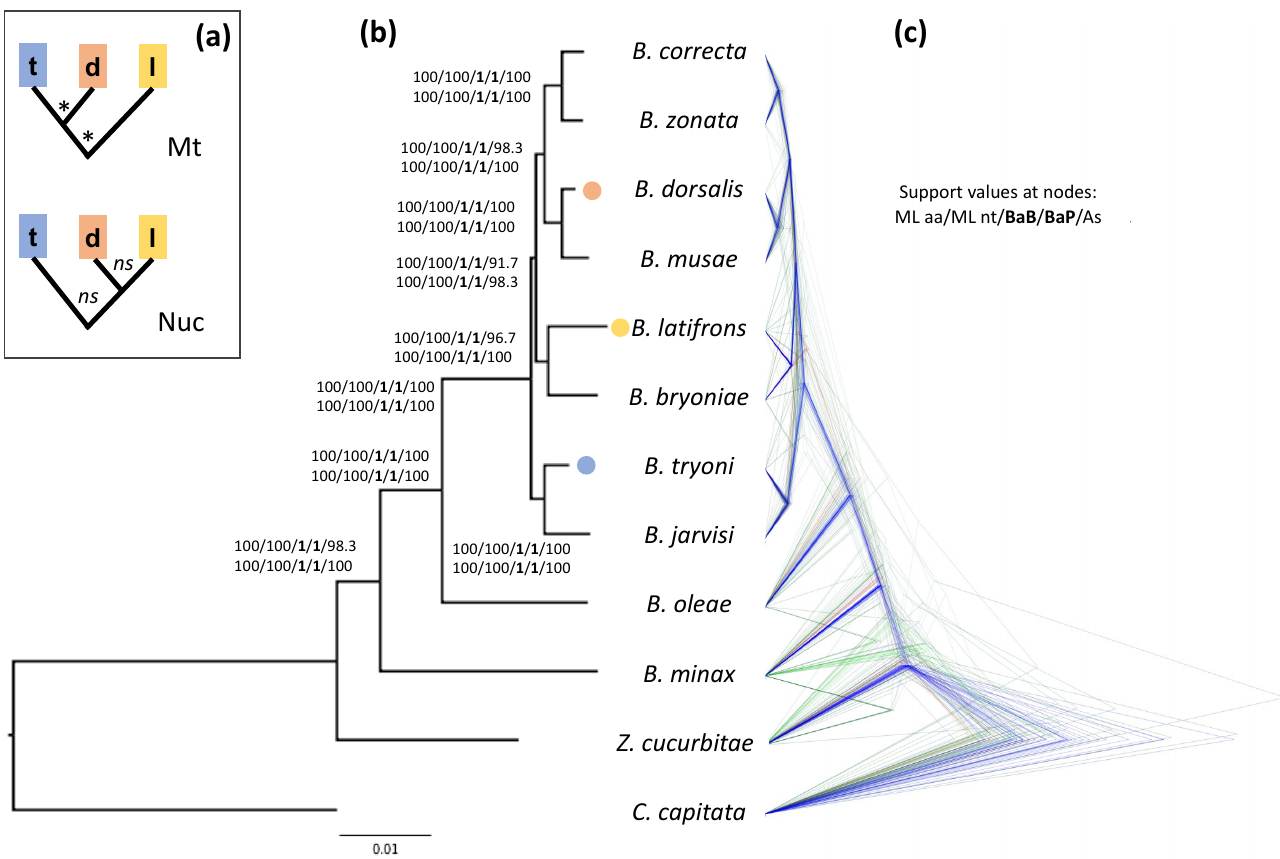
Figure 1. Phylogeny of Bactrocera inferred from the aminoacidic alignments of 110 orthologous nuclear genes. ( a ) Alternative phylogenetic relationships with supported (*) and non-supported (ns) nodes between B. dorsalis (d), B. latifrons (l) and B. tryoni (t) as presented in the literature and based